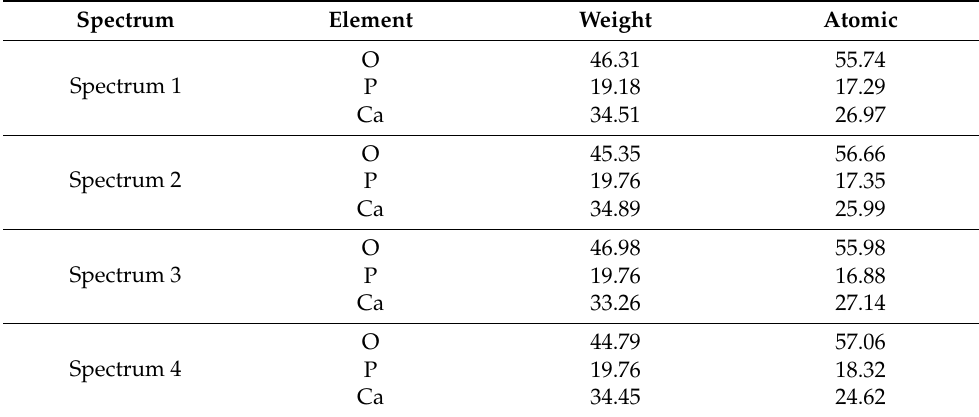
Figure 10. SEM image and elemental analysis of hydroxyapatite coating. Table 6. Elemental analysis of hydroxyapatite coating.